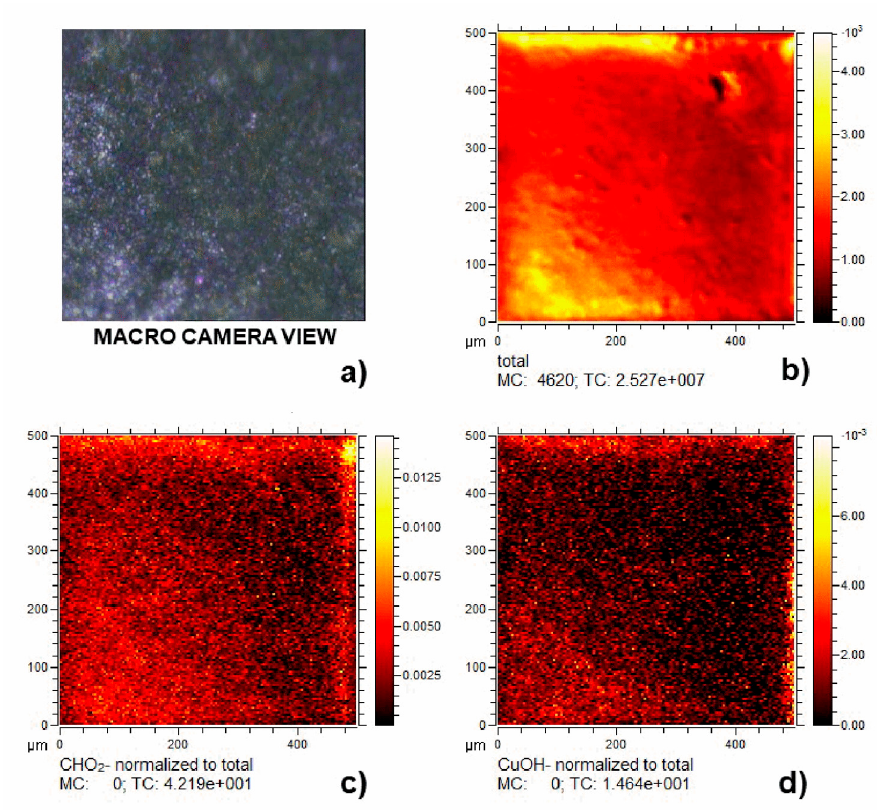
Figure 11. TOF-SIMS ion images recorded in the negative ion mode in the green area. ( a ) Macro camera view of the area where ToF-SIMS images were acquired (area of 500 μ m × 500 μ m), ( b ) total ion image, ( c , d ) ion images of the CHO 2 − ( m/z 45), and CuOH − ( m/z 80) fragment ions ascribed to the presence of verdigris.